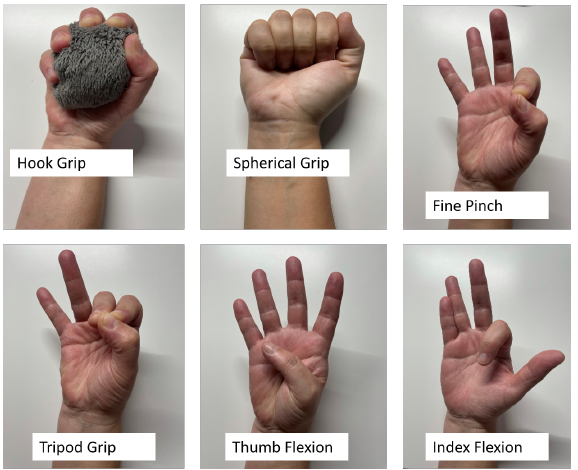
Figure 1. Hand gestures proposed by Al-Timemy et al. in